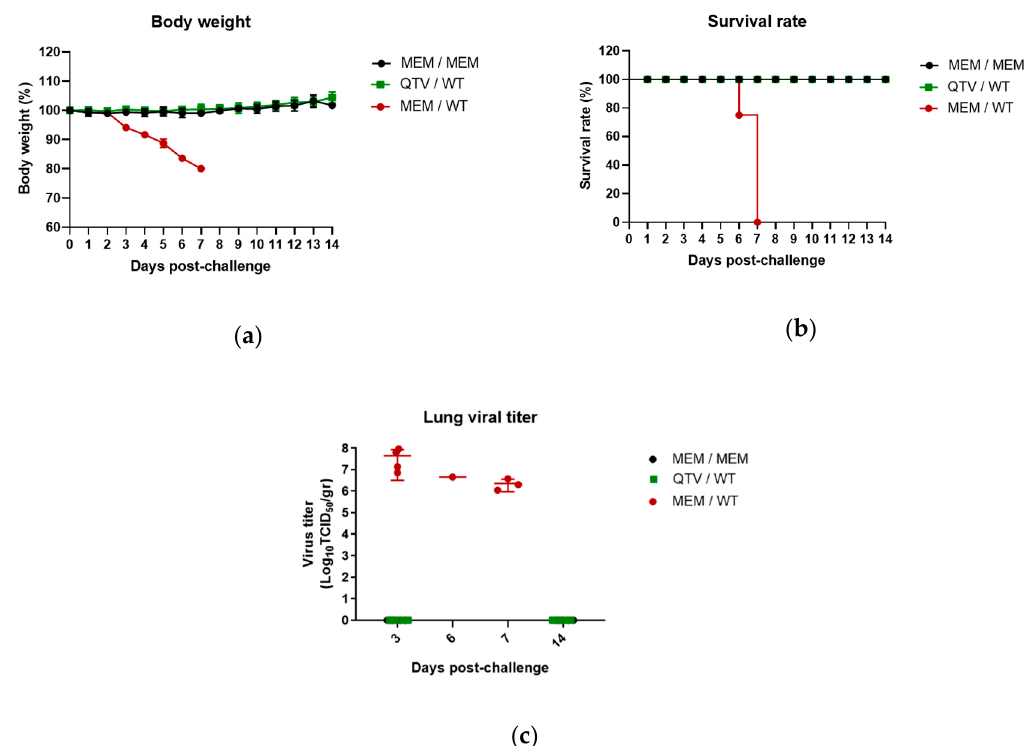
Figure 7. The body weight, survival rate, and lung viral titration of vaccinated mice after viral challenge with the BC15 (H7N9) virus. BALB / c mice were intranasally vaccinated with two doses of MEM (control) or QTV virus (1 × 10 3 PFU). These mice were then intranasally challenged with BC15 (H7N9) (WT) at a lethal dose of 1 × 10 3 PFU. [ n = eight per group, four males and four females for MEM / MEM and MEM / WT], [ n = 10 per group, five males and five females for QTV / WT]. ( a ) The body weight. ( b ) The survival rate. ( c ) The viral titration of homogenized lung samples. Viral titration of the homogenized lung tissue was conducted by the TCID 50 assay. The samples were analyzed in quadruplicate. Four mice per group were humanely euthanized three days post-challenge, while the remaining mice were euthanized 14 days post-challenge. Dots correspond to the individual mouse lung titres. The four dots on three days post-challenge correspond to the four mice that were humanely euthanized. The one dot on six days post-challenge corresponds to one mouse that succumbed to infection. The three dots on seven days post-challenge correspond to three mice that succumbed to infection. The data is shown as the mean ± the standard deviation. The dots correspond to the values obtained from individual mouse samples.